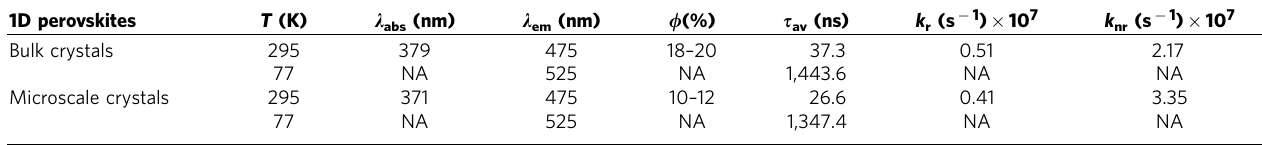
l abs is the wavelength at absorbance maximum; l em is the wavelength at the emission maxima; f is the PL quantum efficiency; t av is the PL lifetime; k r and k nr are the radiative and non-radiative decay rates calculated from equations, k r ¼ f / t and k nr ¼ (1 (cid:2) f )/ t